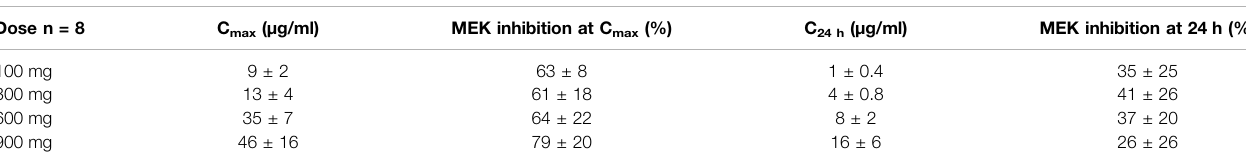
TABLE 6 | Association of PK and PD parameters of zapnometinib in human. Dose n =